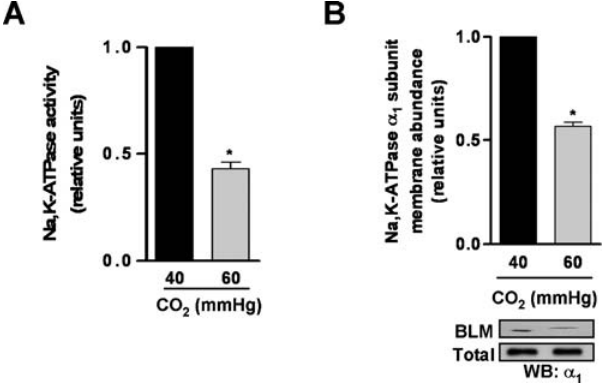
Figure 2. Na,K-ATPase function is impaired in rat lungs exposed to hypercapnic acidosis. (A) Basolateral membranes (BLM) were purified from the peripheral lung tissue of rat lungs exposed to 40 mmHg CO 2 (pH e : 7.4) or 60 mmHg CO 2 (pH e : 7.2), and Na,K-ATPase activity was measured as [ c - 32 P]ATP hydrolysis. Graph represents the mean 6 SEM, (n=3). (B) BLM and total membranes were purified from the peripheral lung tissue of rat lungs treated as (A), and Na,K-ATPase protein abundance was assessed by Western blot. Graph represents the mean 6 SEM, (n=3). Representative blots of Na,K-ATPase a 1 -subunit at the BLM and total membrane protein abundance are shown. pH e : extracellular pH. * p ,